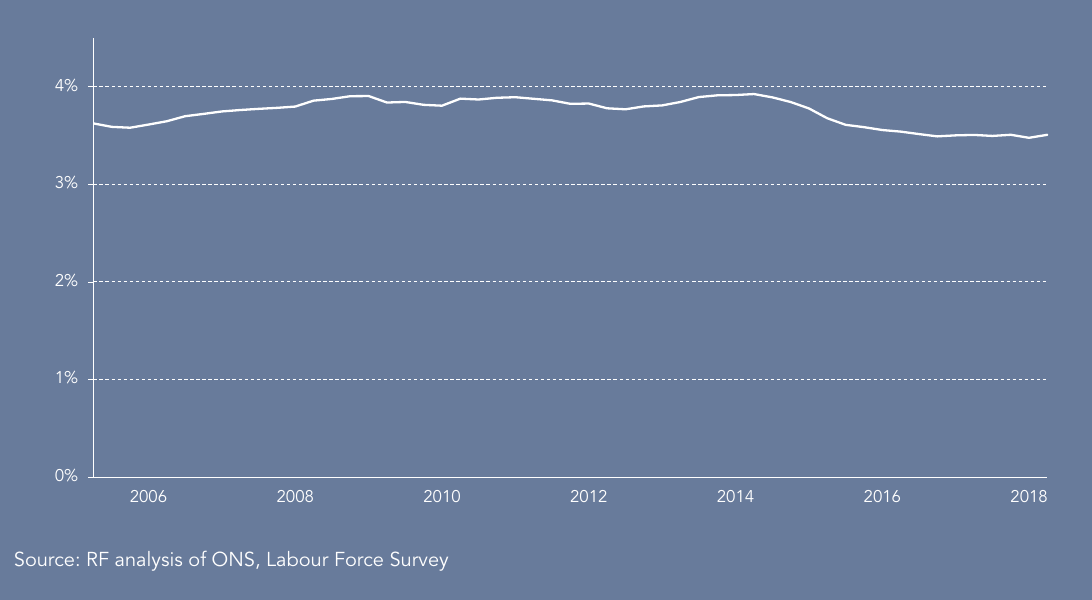
Figure 25: The proportion of people with a second job is small, and has fallen since 2014 Proportion of people in employment with a second job, 16+ year olds